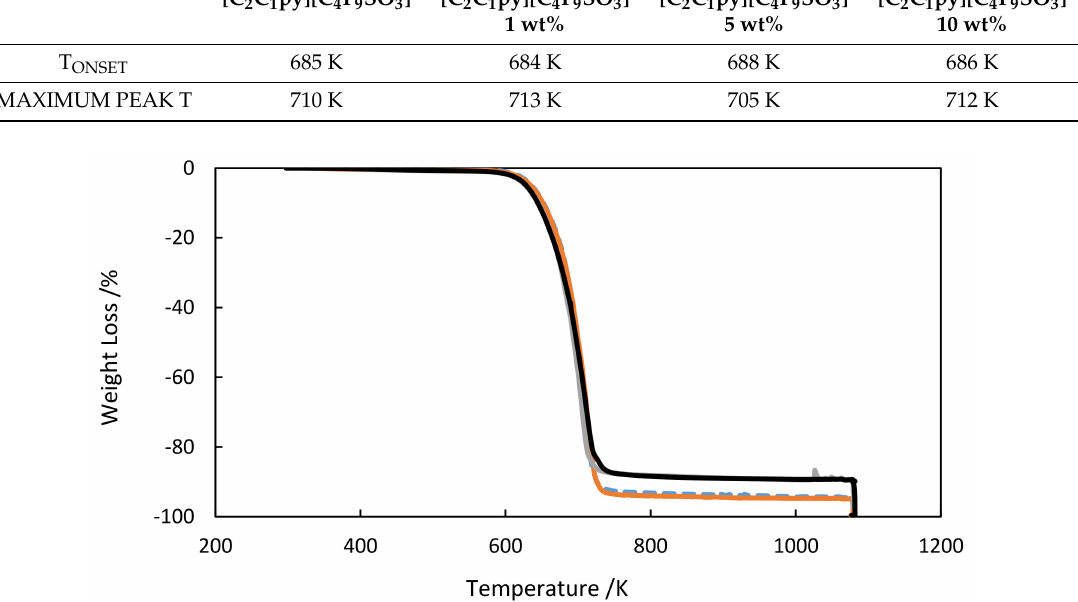
Figure2. Thermogravimetricanalysis(TGA)curvesofxGnP / [C 2 C 1 py][C 4 F 9 SO 3 ]atmassconcentrations: (—) 0 wt%, (—)1 wt%, (—) 5 wt%, (—)10